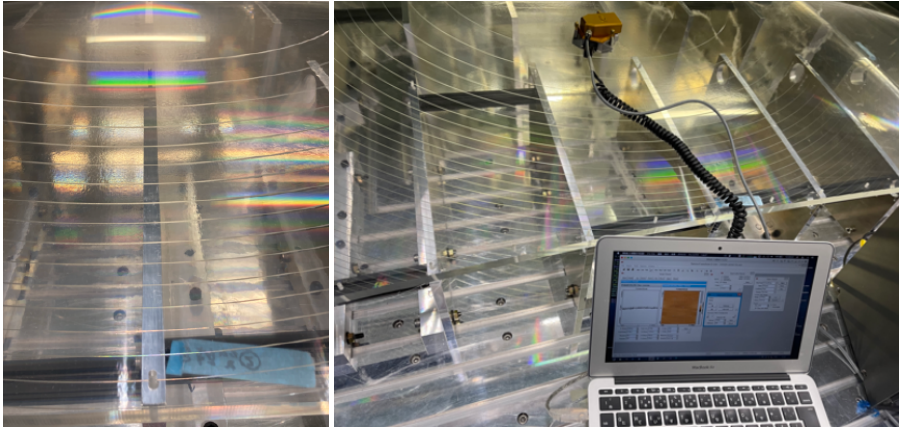
Figure 6. Formation and test of the Fresnel structure. ( Left ): the central segment of the lens. ( Right ): the measuring phase of the surface